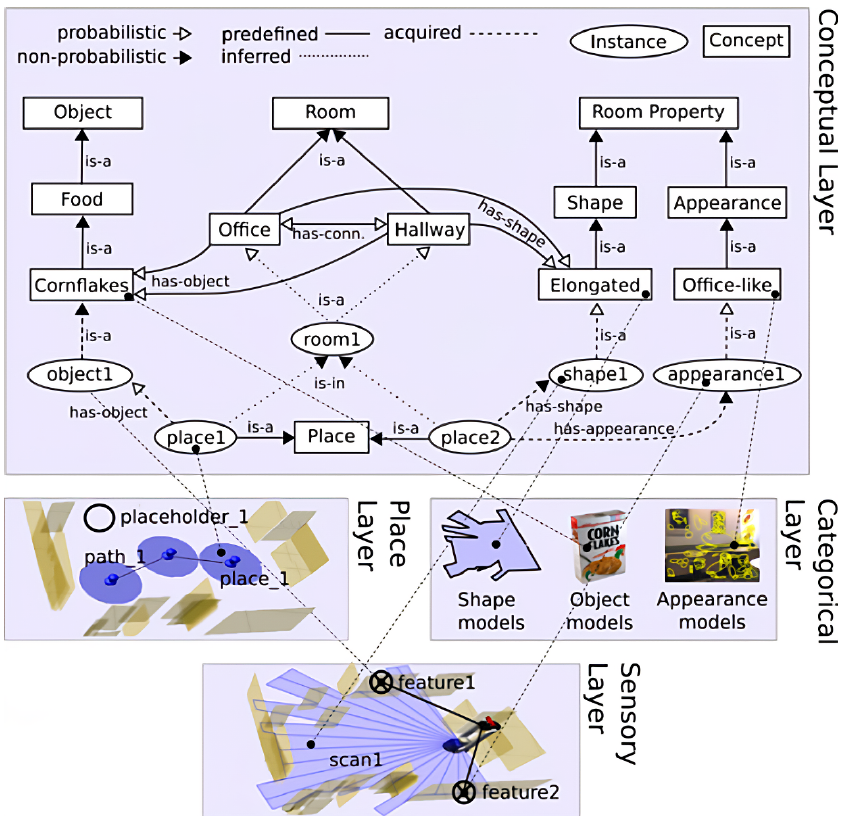
Figure 4. The layered structure of the spatial representation and a visualization of an extract of the conceptual-layer ontology proposed in